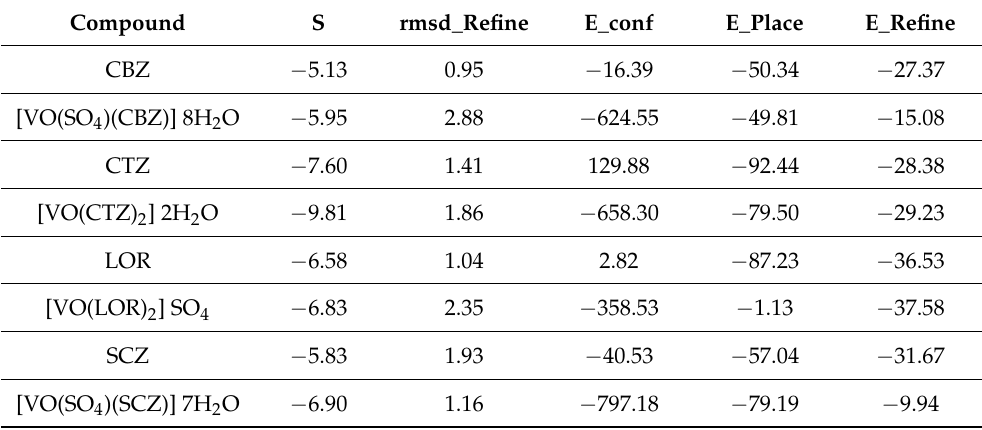
Table 9. Docking score and energies of ligands and their oxidovanadium(IV) complexes with 3IG7